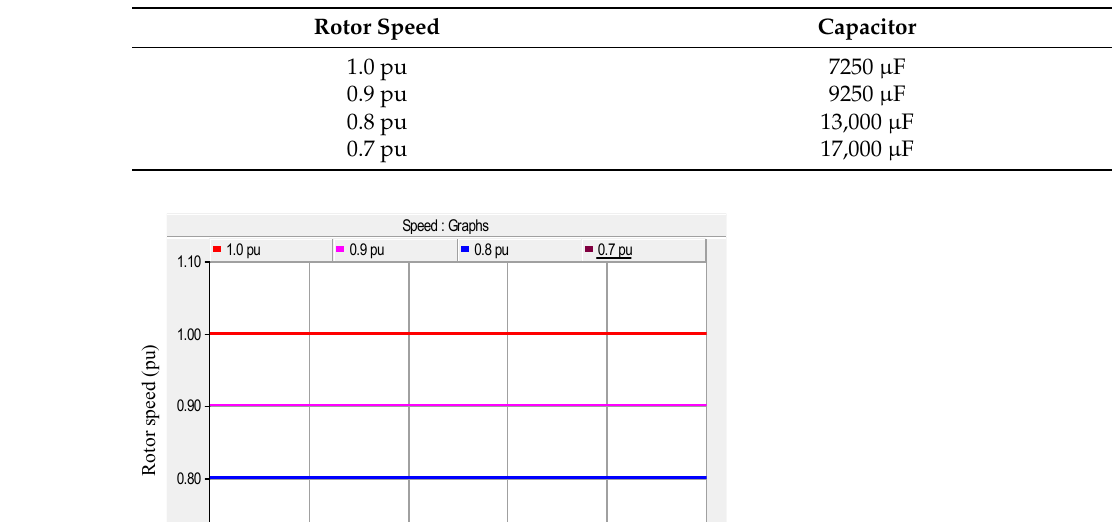
Table 3. Parallel capacitor.